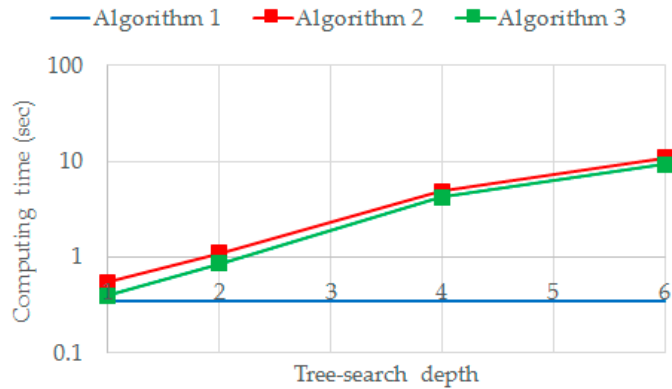
Figure 10. Average computing time per move decision made by the algorithms.